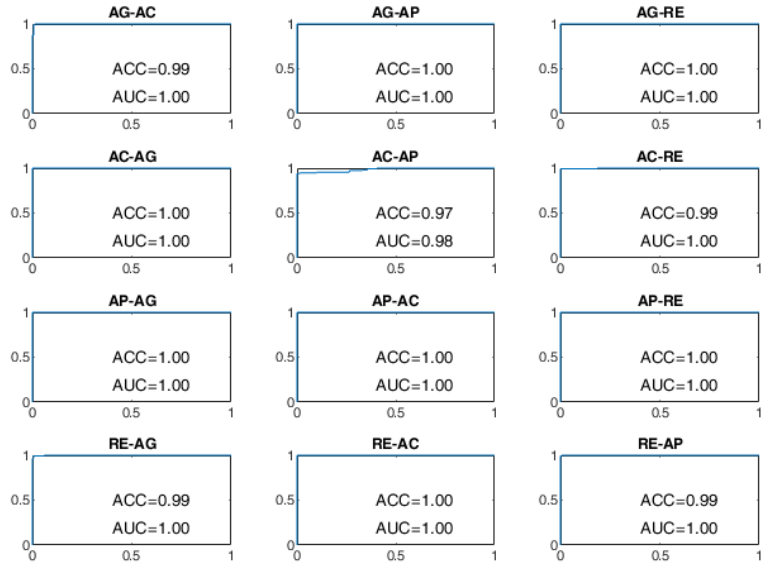
Figure 13 . ROC curves of the BLSTM-AE TCN approach on the DS1 dataset for WD = 70 s.